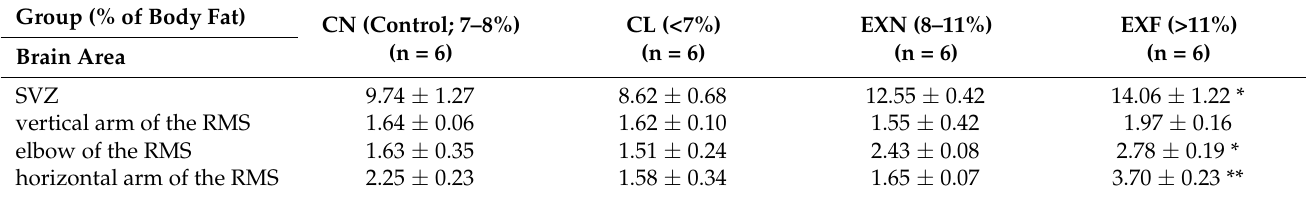
Figure 4. The total number of FJC+ cells in the SZV/RMS neurogenic region in mice with various body conditions. Abbreviations: SVZ—subventricular zone; RMS—rostral migratory stream; (CN) control group of mice characterized by normal weight and physiological percentage of body fat deposits; (CL) control group of mice characterized by reduced weight and reduced body fat deposits; (EXN) experimental group of mice characterized by normal weight and moderately elevated body fat deposits; (EXF) experimental group of mice characterized by markedly elevated weight and body fat deposits. Data are shown as mean ± SEM. Statistical significance of differences between experimental and control groups: * p ≤ 0.05, *** p ≤ 0.001. Table 4. The number of NADPH-d+ cells in the SVZ/RMS neurogenic region in mice with various body conditions. Abbreviations: SVZ—subventricular zone; RMS—rostral migratory stream; (CN) control group of mice characterized by normal weight and physiological percentage of body fat deposits; (CL) control group of mice characterized by reduced weight and reduced body fat deposits; (EXN) experimental group of mice characterized by normal weight and moderately elevated body fat deposits; (EXF) experimental group of mice characterized by markedly elevated weight and body fat deposits. Data are shown as mean ± SEM. Statistical significance of differences between experimental and control groups: * p ≤ 0.05, ** p ≤